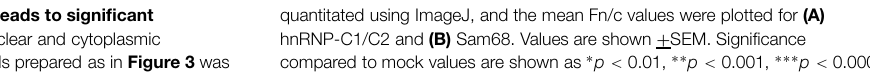
time points was measured. RNA was collected from HRV2 or HRV16 infected Ohio-HeLa cells, reversed transcribed and used in real-time PCR reactions, using primers specific for